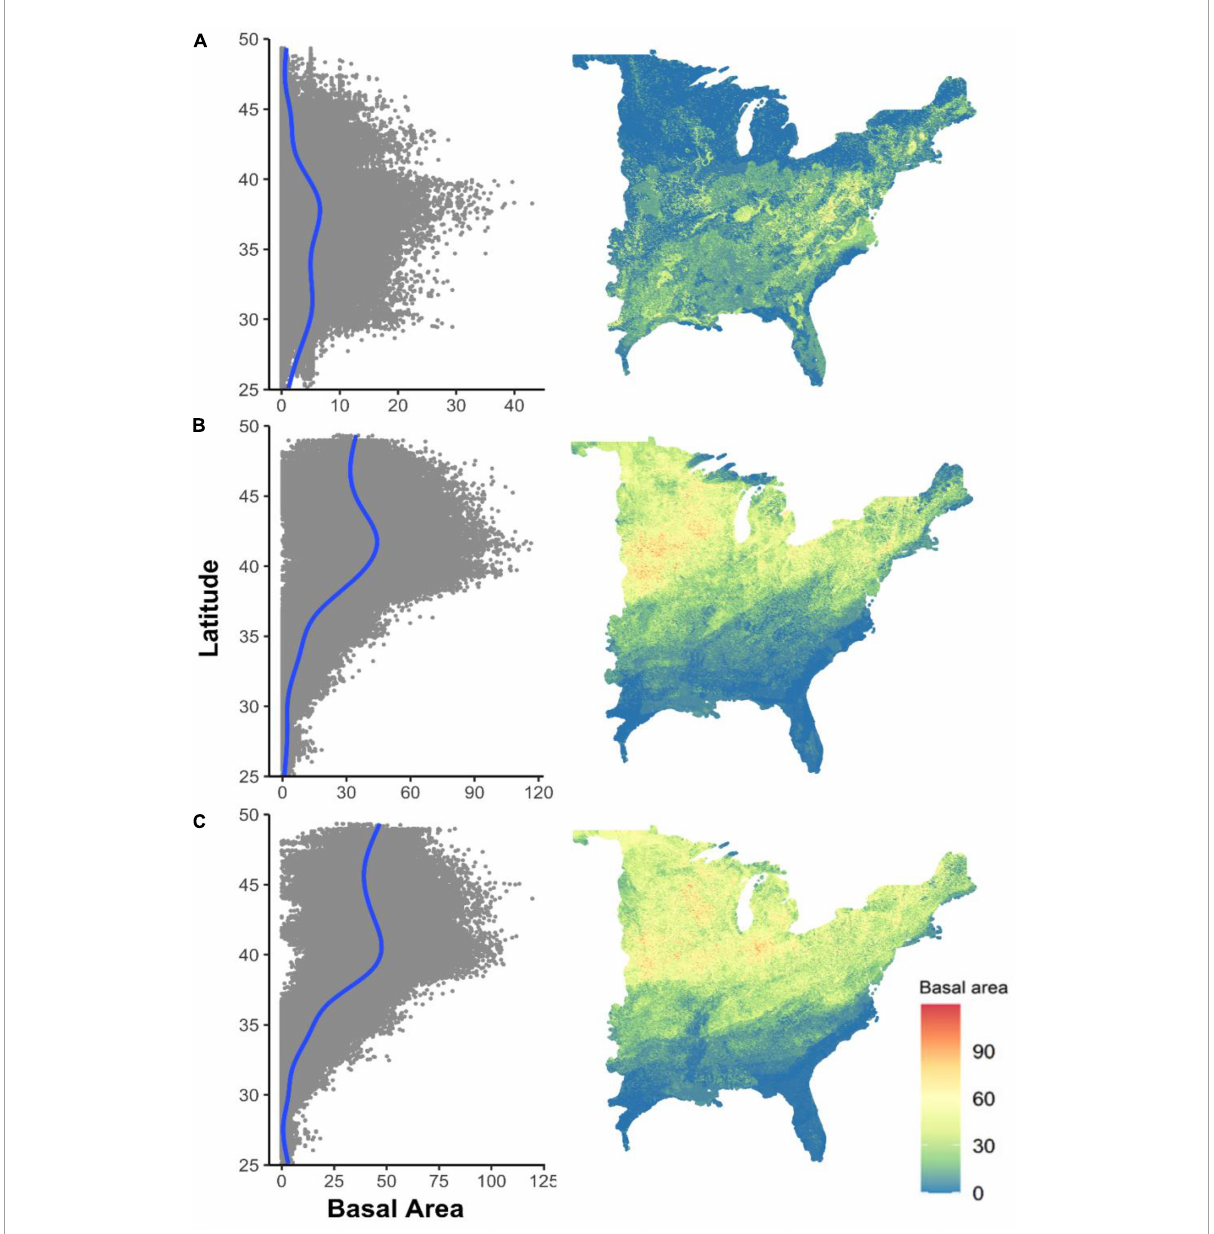
FIGURE4 Predicted local basal area (m 2 /ha) of black walnut based on current climate (A) and future climate scenario RCP4.5 (B) and RCP8.5 (C) . Right panels map the geographic distribution of the predicted basal area, with latitudinal occurrences (gray points) and associated latitudinal trendlines (blue curves) shown in the left